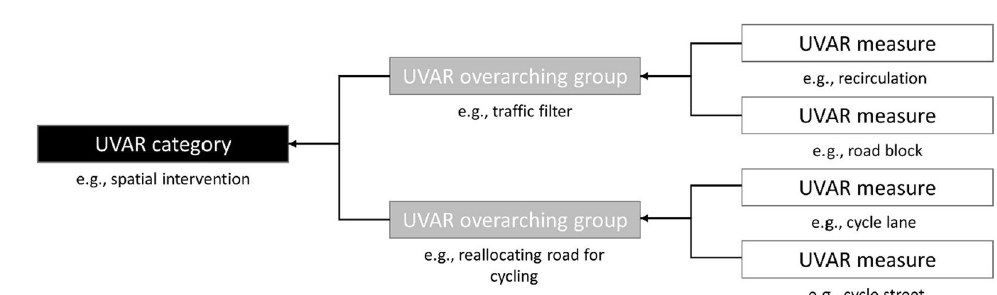
Fig. 2 Schematic for the UVAR taxonomy